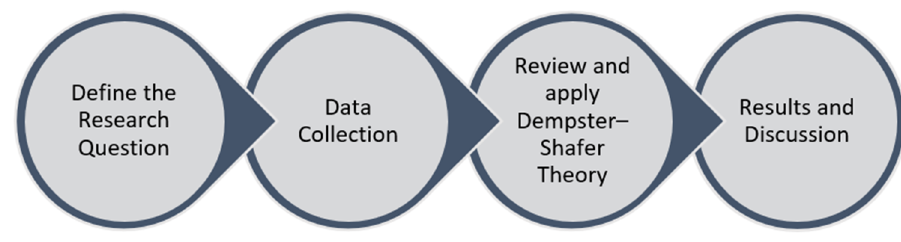
Figure 1. Research method used in this paper.